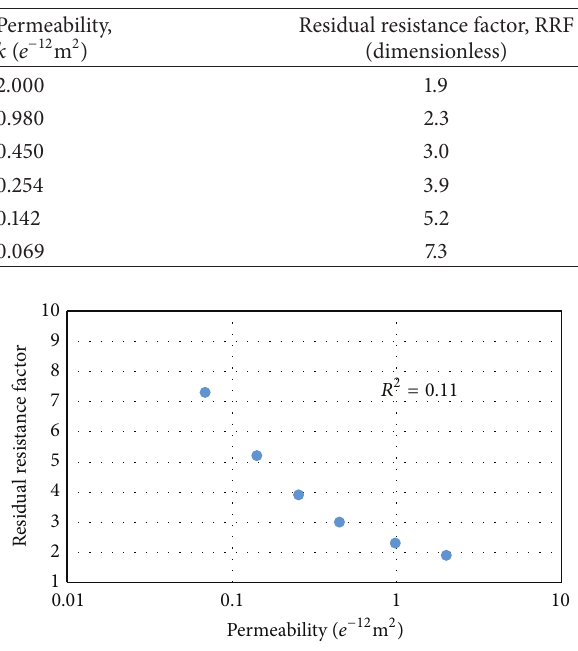
Table 1: Experimental data for polymer adsorption.